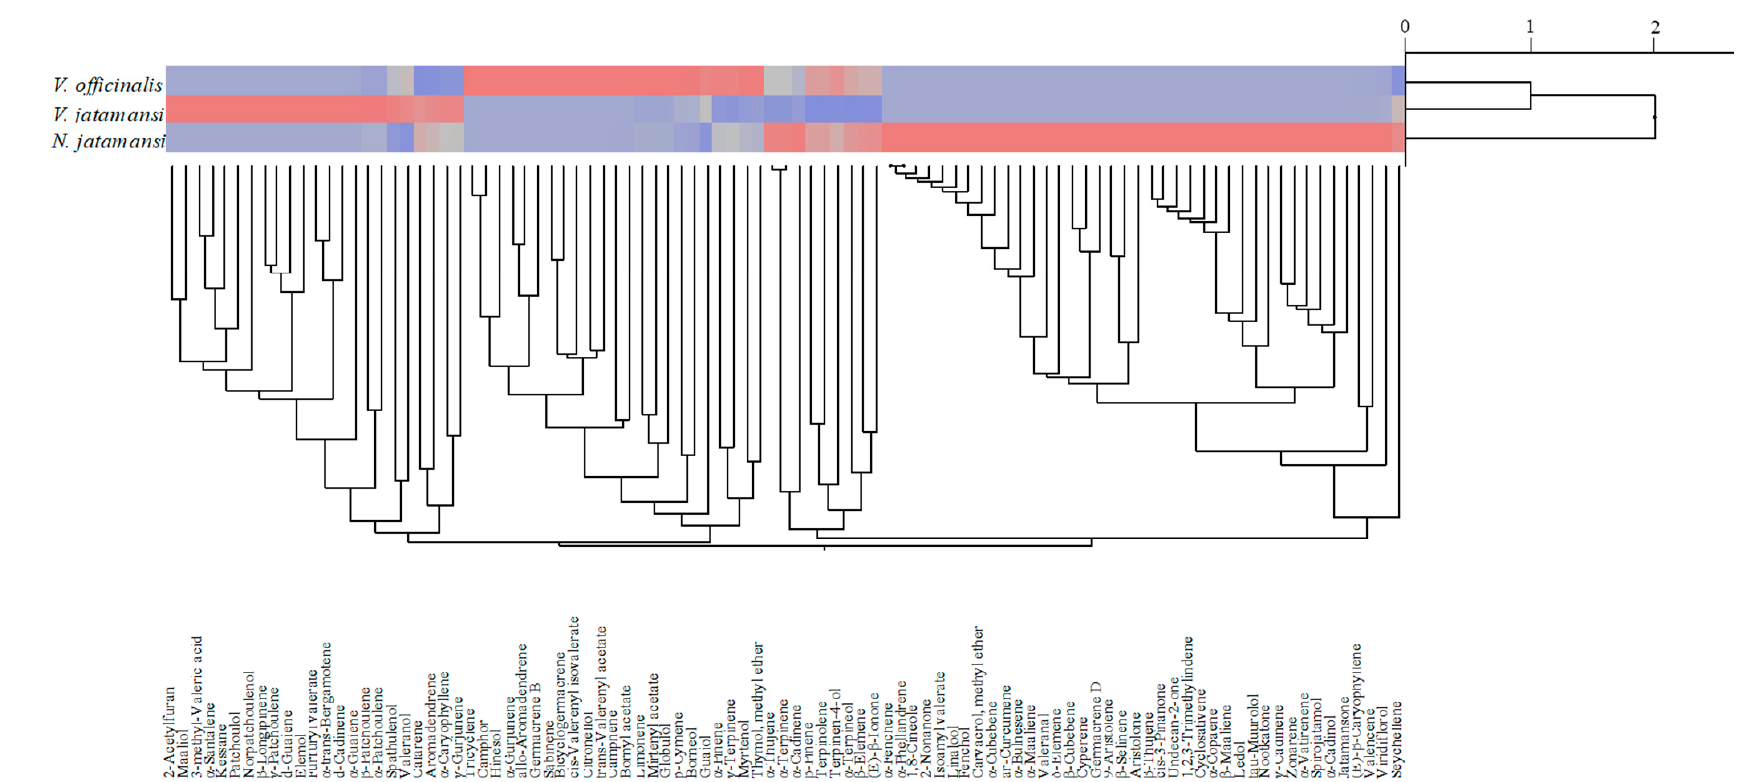
Figure 5. Agglomerative hierarchical clustering analysis of the three Caprifoliceae essential oils (EOs) investigated: Vo, Vj and Nj.